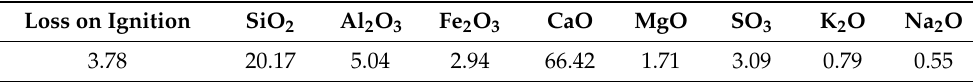
Table 1. Chemical characteristics of ordinary Portland